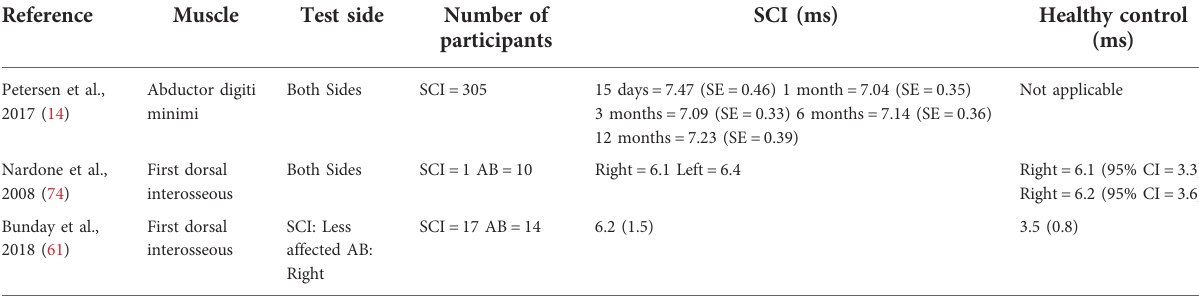
TABLE 4 Central motor conduction time in individuals with and without spinal cord